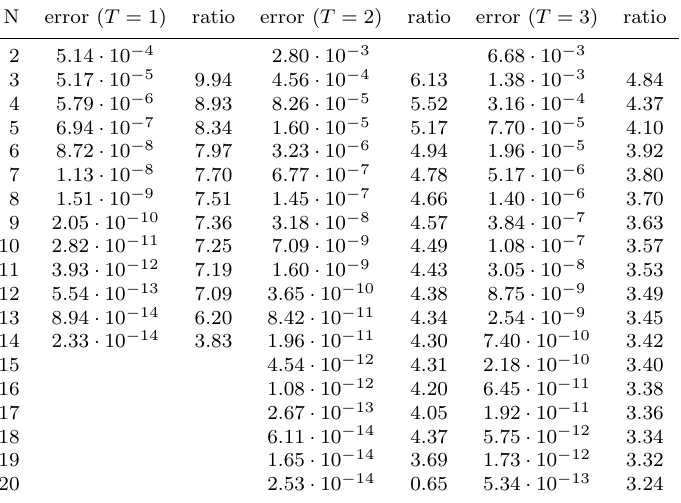
Table 2. Errors and ratios for equation (6.2) with T = 1, T = 2 and T = 3. N error ( T = 1) ratio error ( T = 2) ratio error ( T = 3)